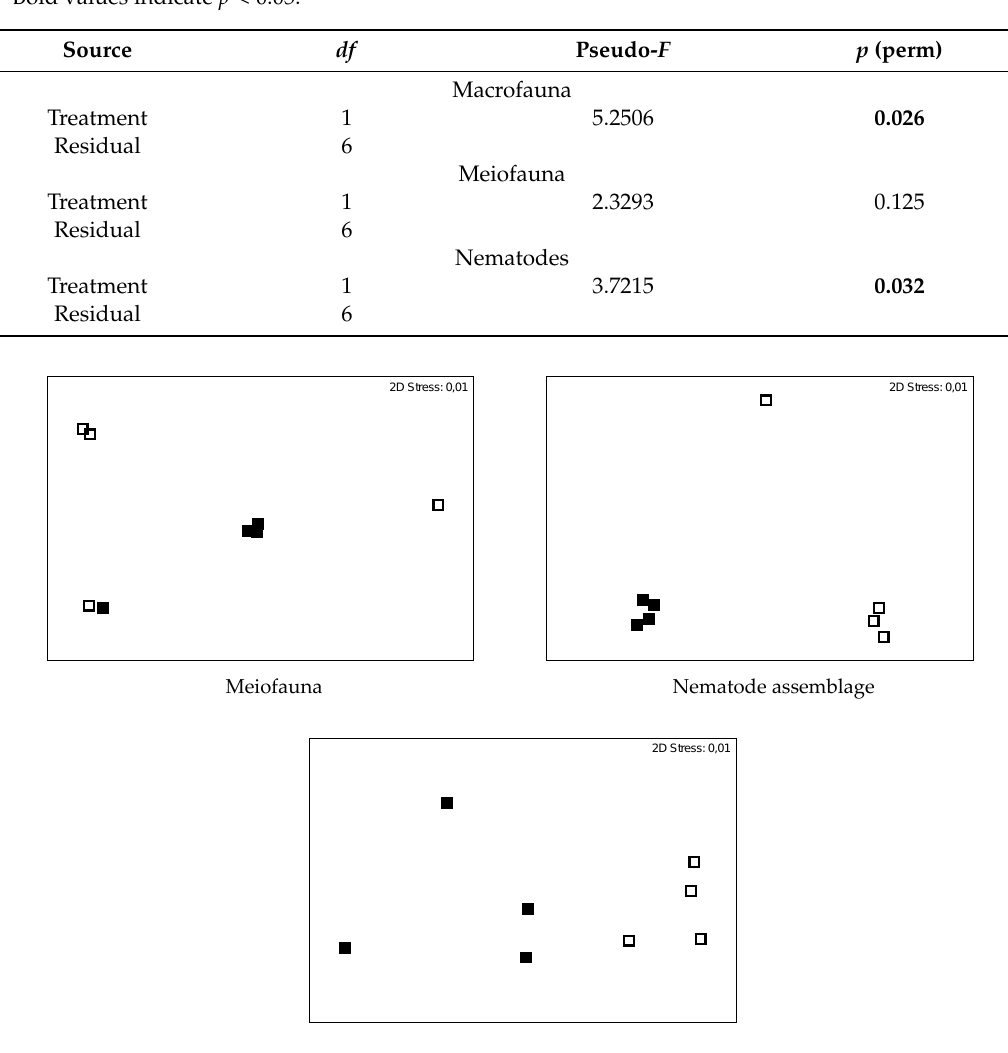
Table 4. Differences in multivariate structure of macrofauna, meiofauna and nematode assemblages from the different environments using one-way PERMANOVA. Data were log (x + 1) transformed. Bold values indicate p < 0.05.